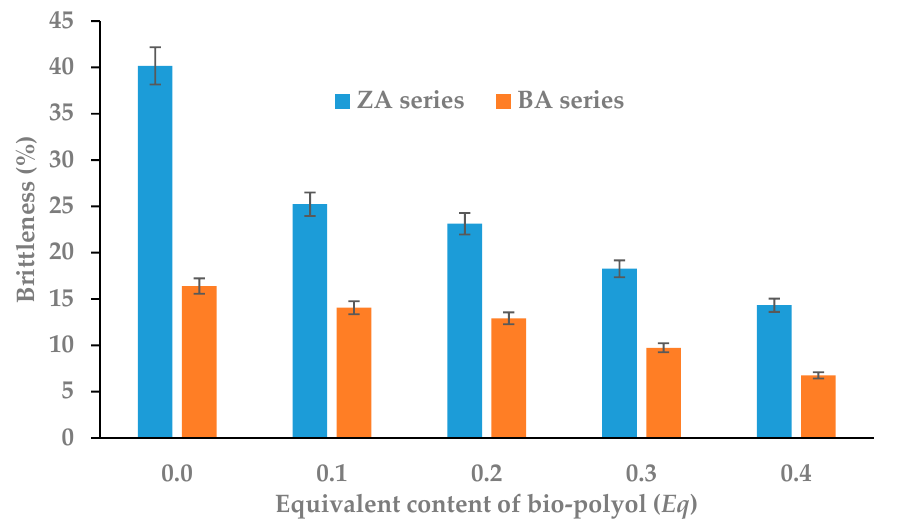
Figure 3. Dependence between bio-polyol content and brittleness of RPU/PIR foams.